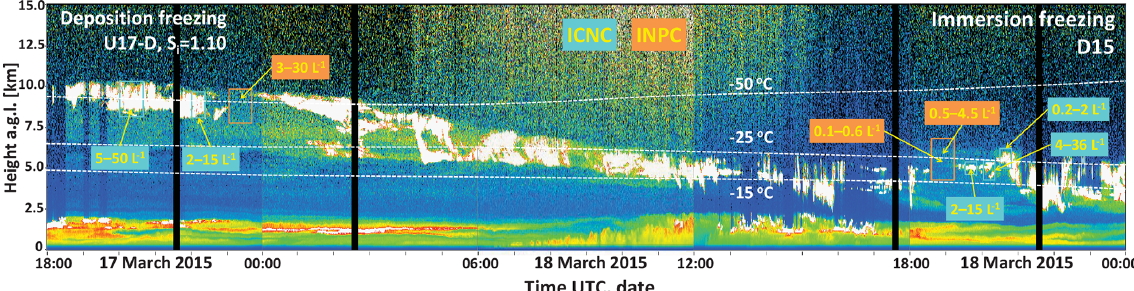
Figure 14. Continuous cirrus and mixed-phase cloud observations for 30h over Nicosia on 17–18 March 2015 (also shown in Fig. 5e, g, and i). The air mass from 5 to 10km height was replaced (starting at great heights) by dust-free, dry air advected from Turkey and southern Europe between 02:00 and 11:00UTC on 18 March, leading to the impression of a descending dust and cirrus layer. Several INPC and ICNC values estimated from the lidar observations are given as numbers determined for the indicated orange (INPC) and blue (ICNC) boxes. The deposition nucleation U17-I(d) parameterization is used on 17 March (at 9–10km height for S i = 1 . 1) and the immersion freezing D15 parameterization is applied in the evening data analysis on 18 March (at 5–6km height). Dashed white lines show the GDAS1 temperature isolines with a 3h